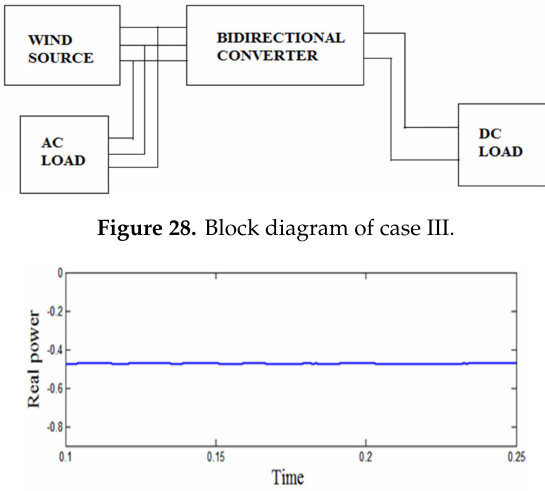
Figure 29. Real power from